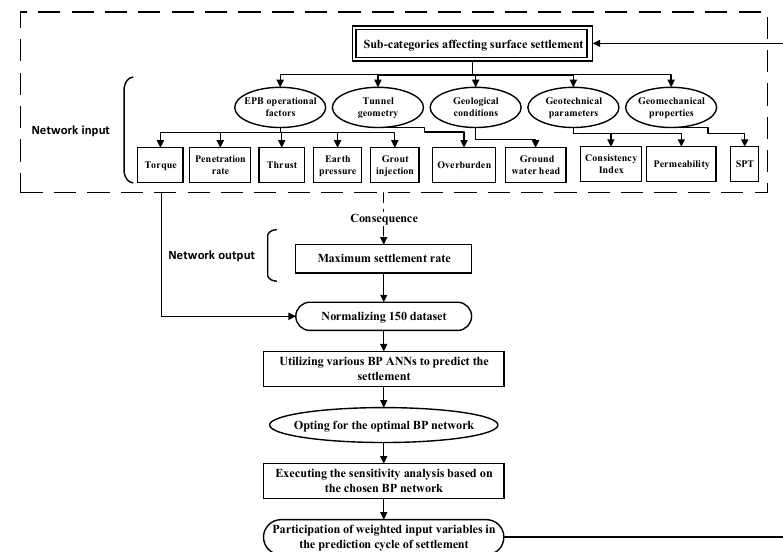
Figure 5. The concise method framework suggested in this research.